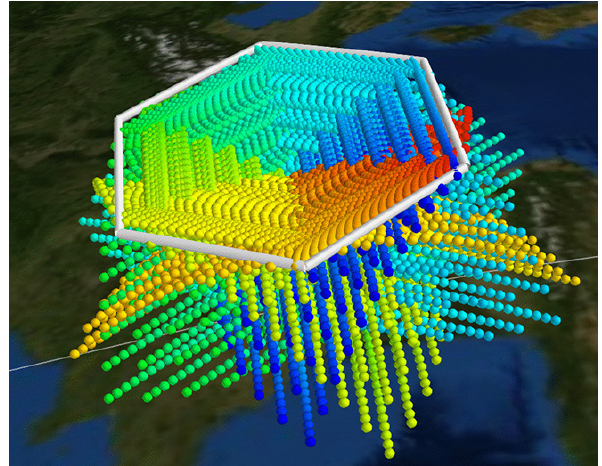
Figure 5. Visualisation of a hexagonal flight pattern and corre- sponding tangent points. Each colour corresponds to limb observa- tions obtained for one flight segment. For example, red points cor- respond to measurements made during the first flight segment and blue points correspond to measurements made during the last flight segment. The tangent point density is highest in a 2–3km thick layer below the flight level. For details see Ungermann et al. (2010).